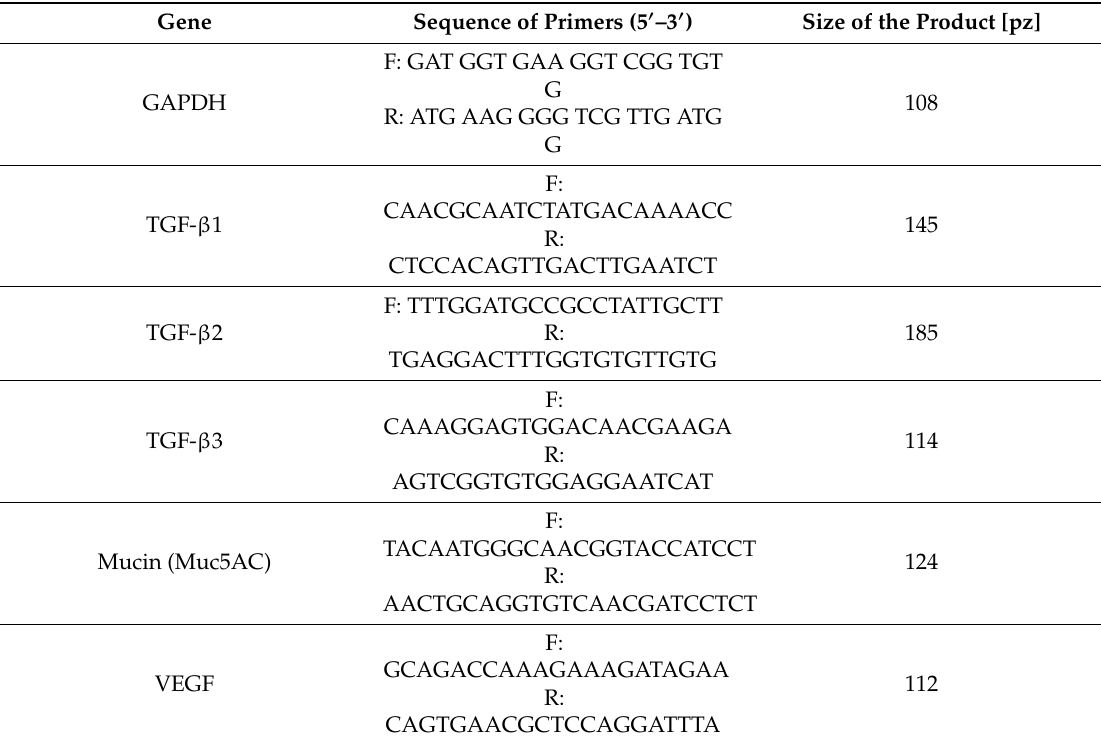
Table 6. Sequences of primers used for real-time